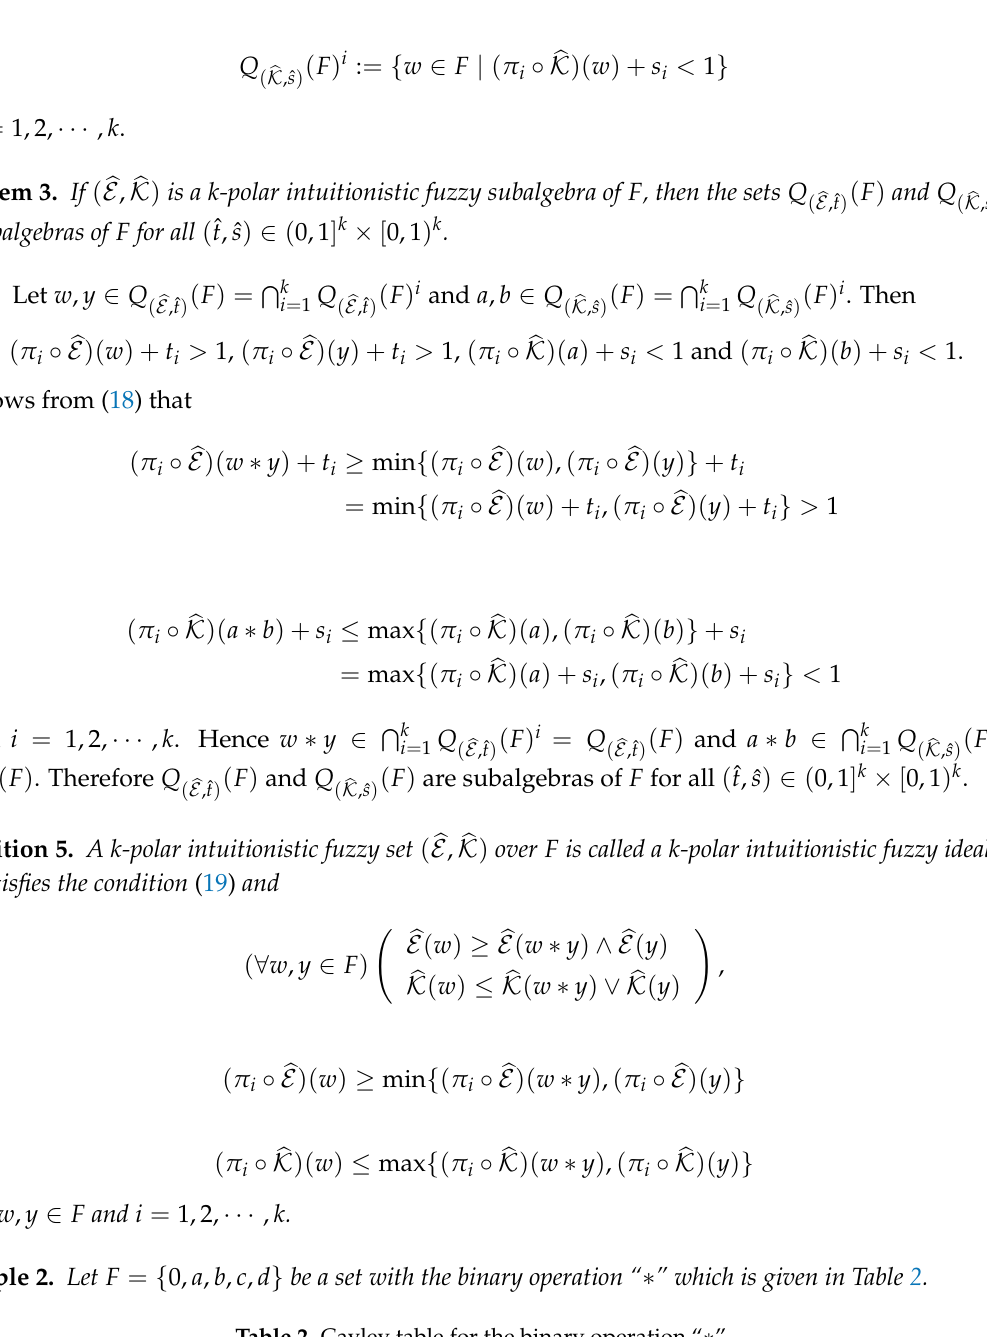
Table 2. Cayley table for the binary operation “ ∗